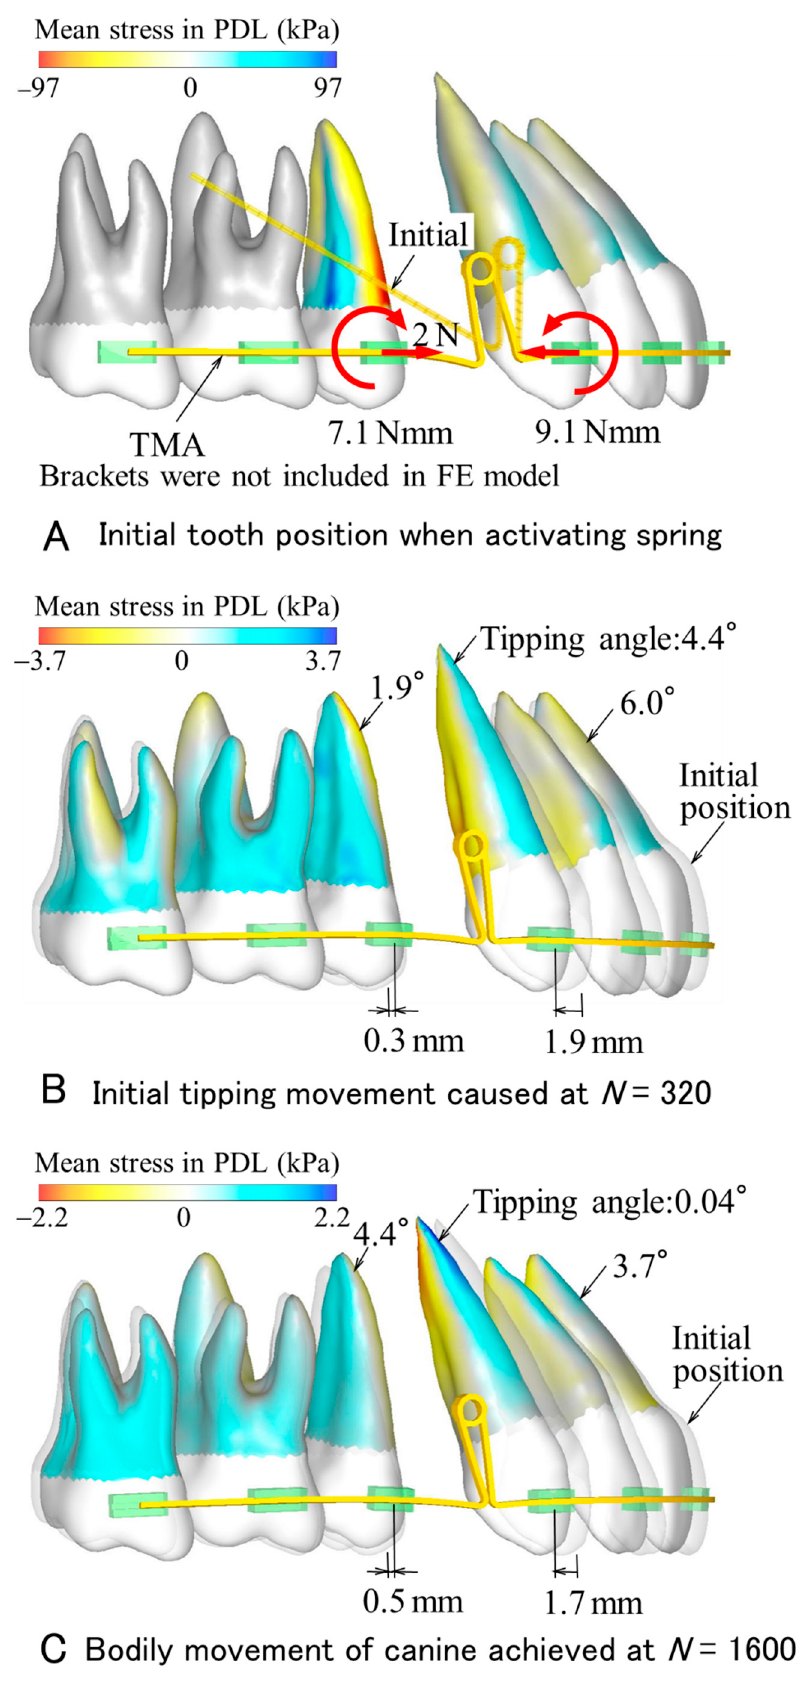
Figure 4. Tooth movement produced by TMA spring.